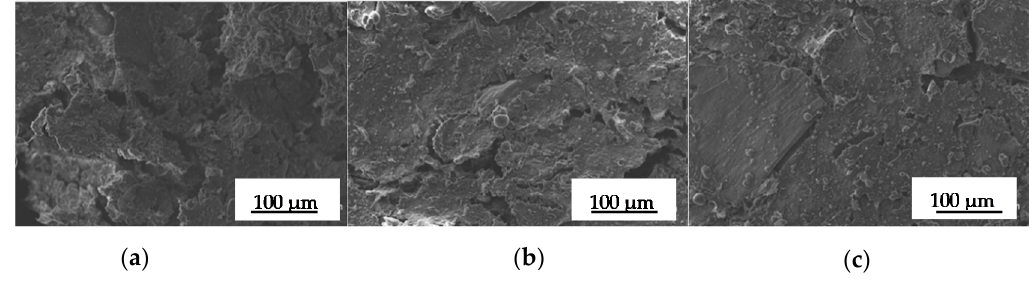
Figure 5. SEM micrographs after lyophilization of the different samples at ( a ) 100 ° C; ( b ) 130 ° C; ( c ) 150 ° C.